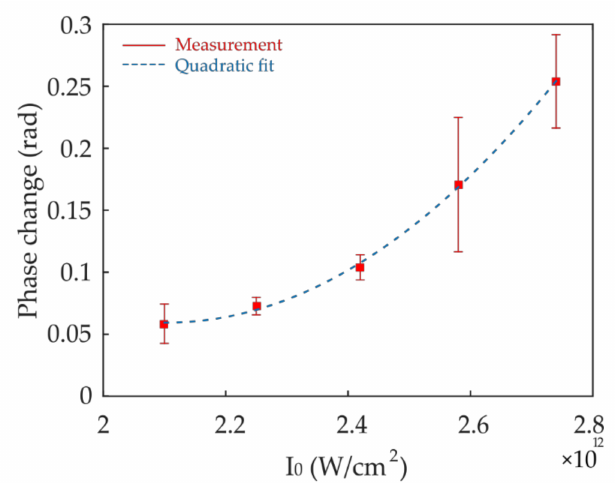
Figure 8. Plot of the measured phase change in the waveguides as a function of the writing intensity. The error bar indicates the standard deviation among three di ff erent waveguides. Dashed line shows a quadratic